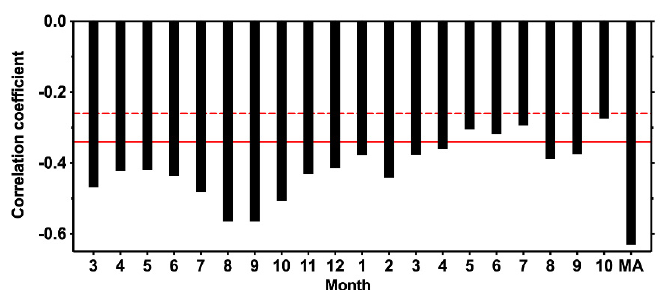
Figure 6. Correlations between TRW chronology and the monthly scPDSI records from the previous March to the current October during their common period 1957–2014. MA (previous May to current April) represents the target months for reconstruction. The solid (dash) line denotes the 0.01 (0.05) significance level, respectively.